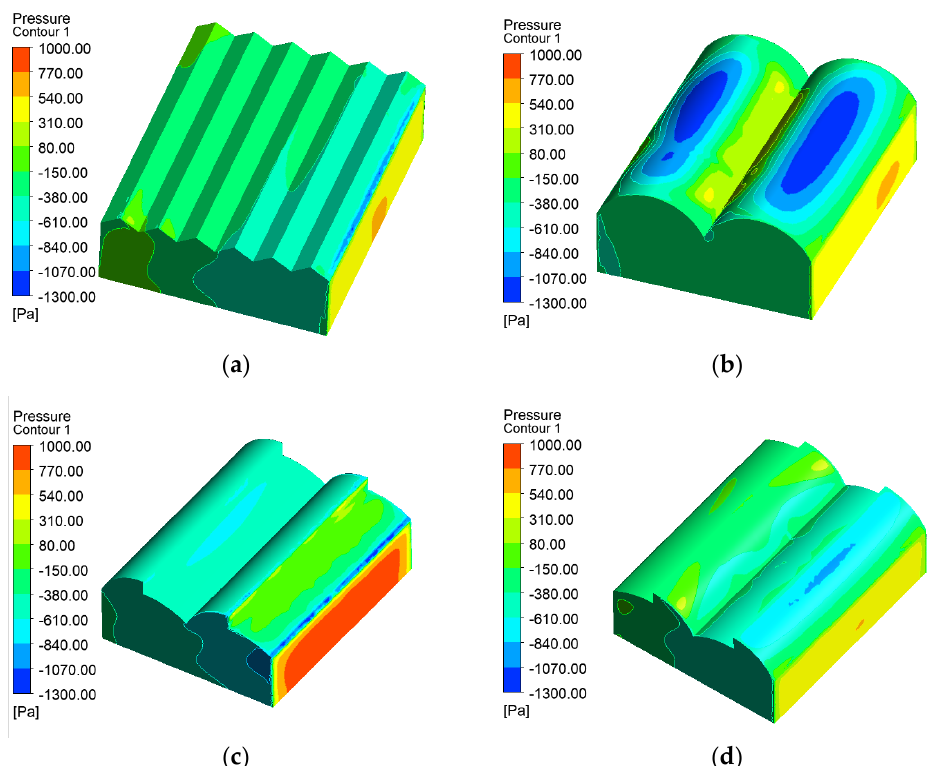
Figure 7. Counters of wind pressure distribution on the greenhouse surface in 0°-wind. ( a ) Venlo Type ( b ) Round-arch Type ( c ) Saw-tooth Type ( d ) Saw-tooth Type (180° -wind).